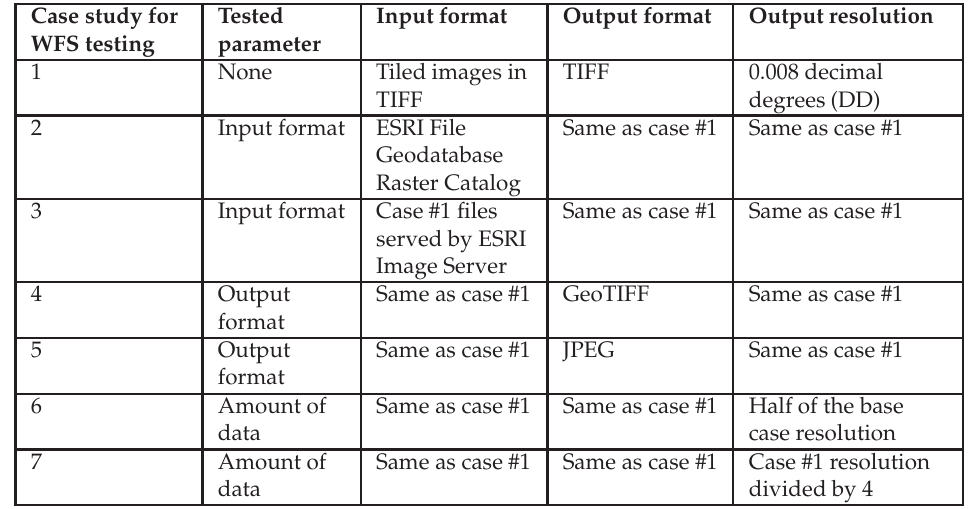
Table 3: Summary of the WCS testing scenarios. Case #1 is the “base